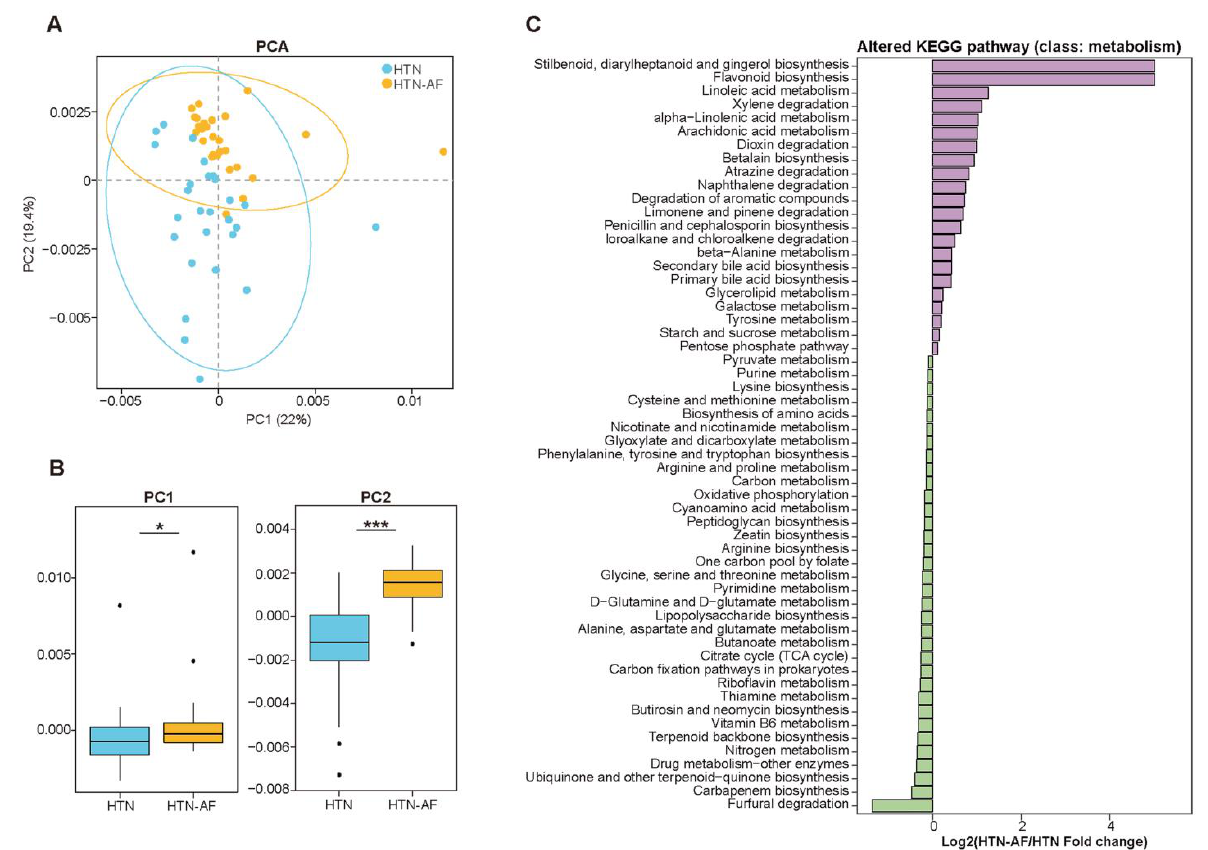
Figure 4. The shift in gut microbial function in HTN-AF patients. ( A , B ) PCA score plots based on annotated KEGG orthology ( A ) and related comparison of PC1 and PC2 ( B ) revealed the altered gut microbial function between the two groups. ( C ) Log2 fold-change of differential KEGG pathway (class: metabolism) between HTN and HTN-AF groups ( p < 0.05). Wilcoxon rank sum test. *, p < 0.05; ***, p < 0.001.